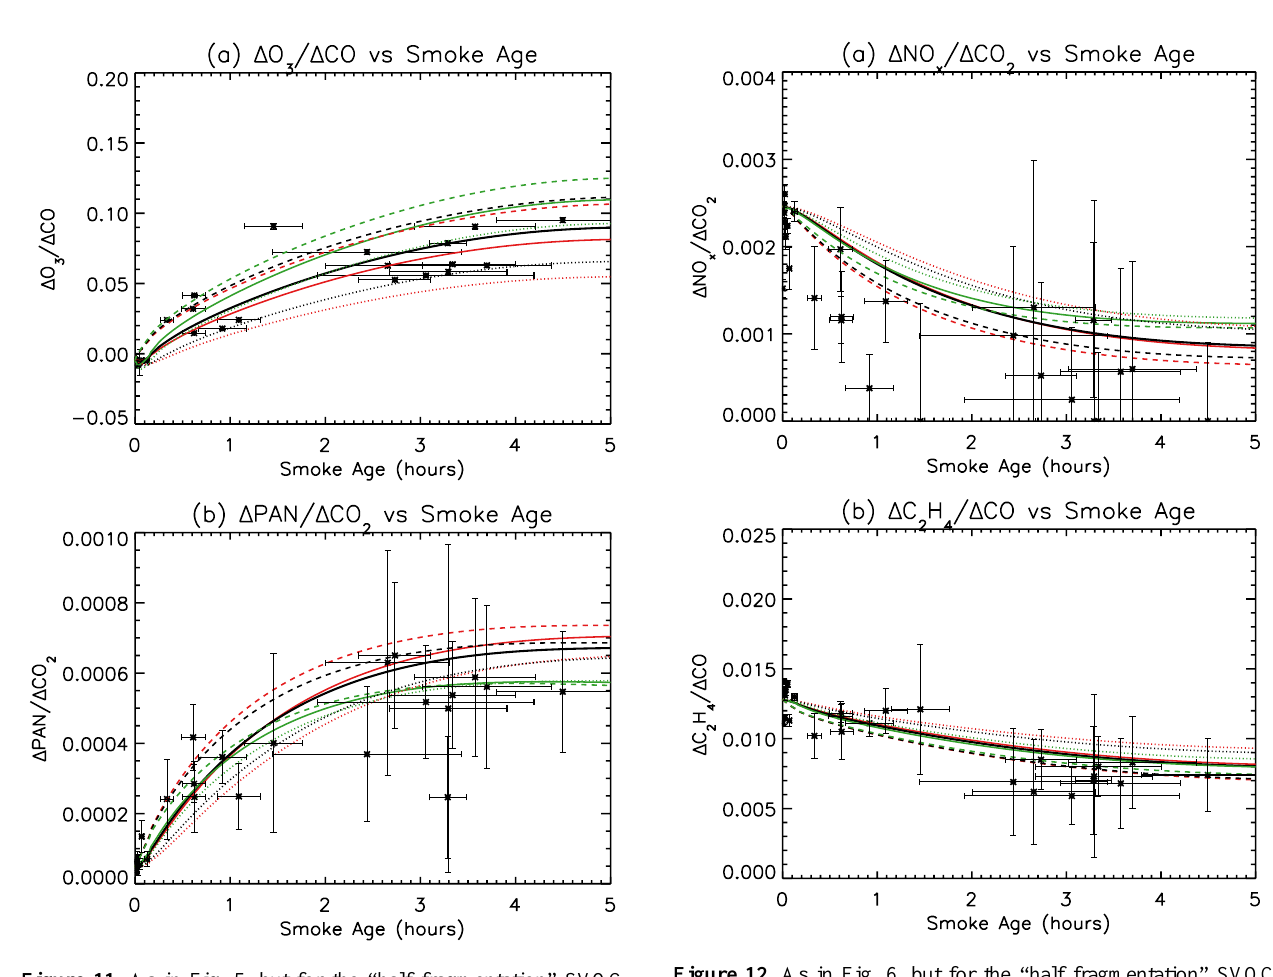
Figure 11. As in Fig. 5, but for the “half fragmentation” SVOC mechanism rather than no fragmentation (see Table 2).